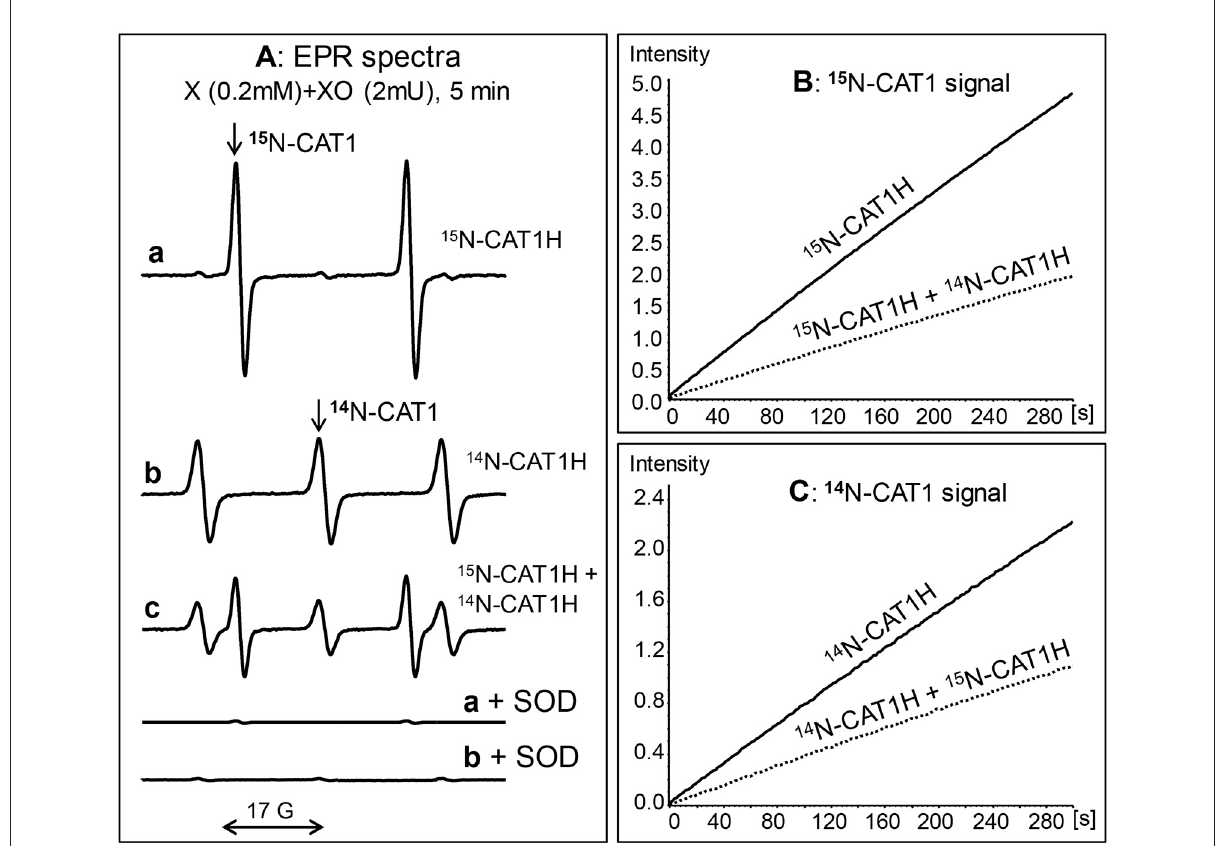
FIGURE2 Simultaneous detection of superoxide by 15 N- and 14 N- hydroxylamine spin probes. (A) EPR spectra of hydroxylamine spin probes incubated with xanthine (0.2mM) and xanthine oxidase (2 mUnits/ml) for 5 min: 0.2mM 15 N-CAT1H (a), 0.2mM CAT1H (b), and 0.2mM 15 N-CAT1H plus 0.2mM 14 N-CAT1H (c). Accumulation of both 15 N-CAT1 and 14 N-CAT1 was inhibited in the presence of superoxide dismutase (SOD, 50 units/ml). (B) EPR intensity of 15 N-CAT1 in the sample with xanthine oxidase superoxide generating system and 15 N-CAT1H